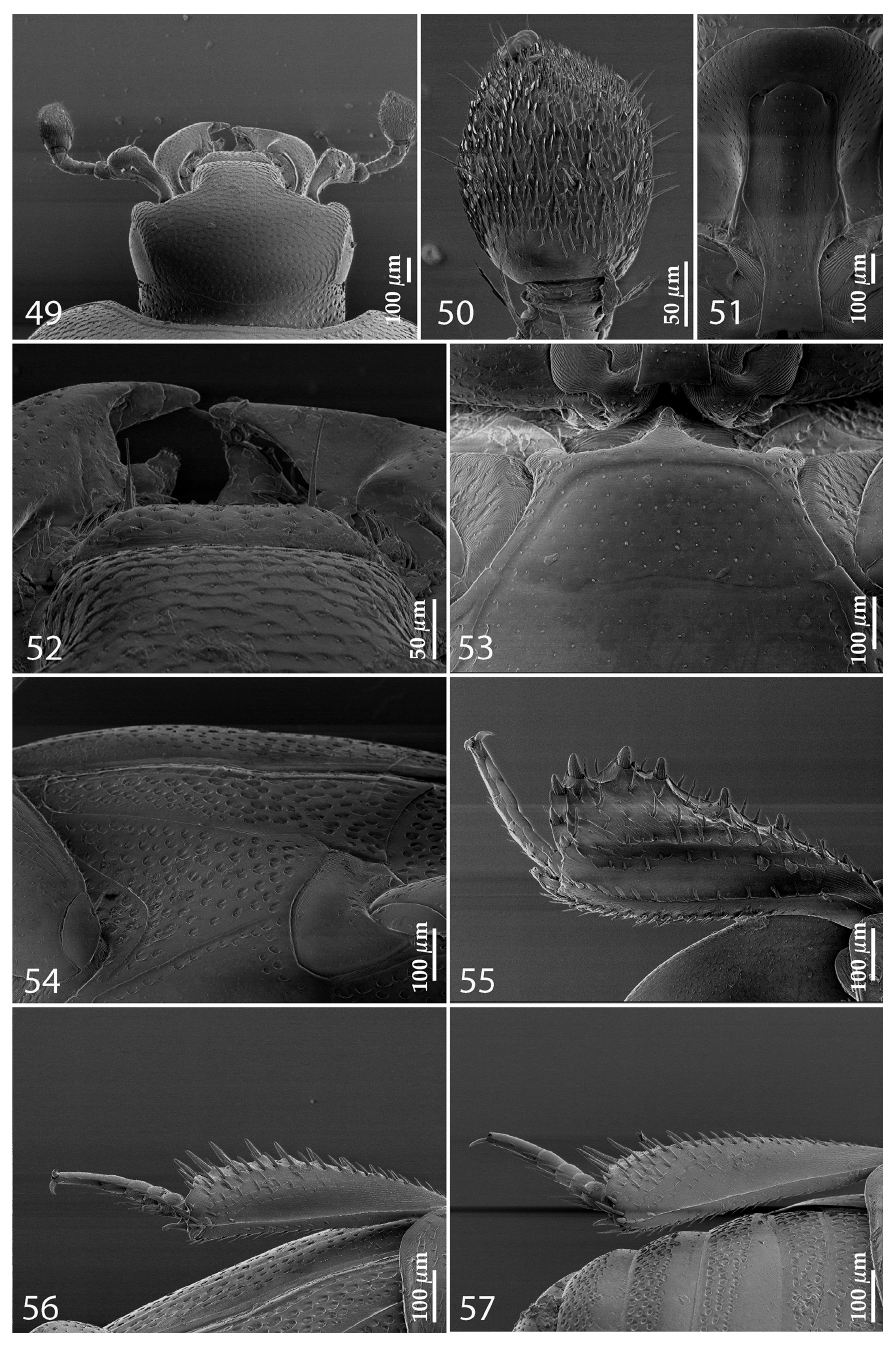
Figures 49–57. 49 Euspilotus ( Neosaprinus ) rubriculus (Marseul, 1855) head, dorsal view 50 antennal club, dorsal view 51 prosternum 52 clypeus + labrum 53 mesoventrite 54 lateral disc of metaventrite + metepisternum 55 protibia, ventral view 56 mesotibia, ventral view 57 metatibia, ventral